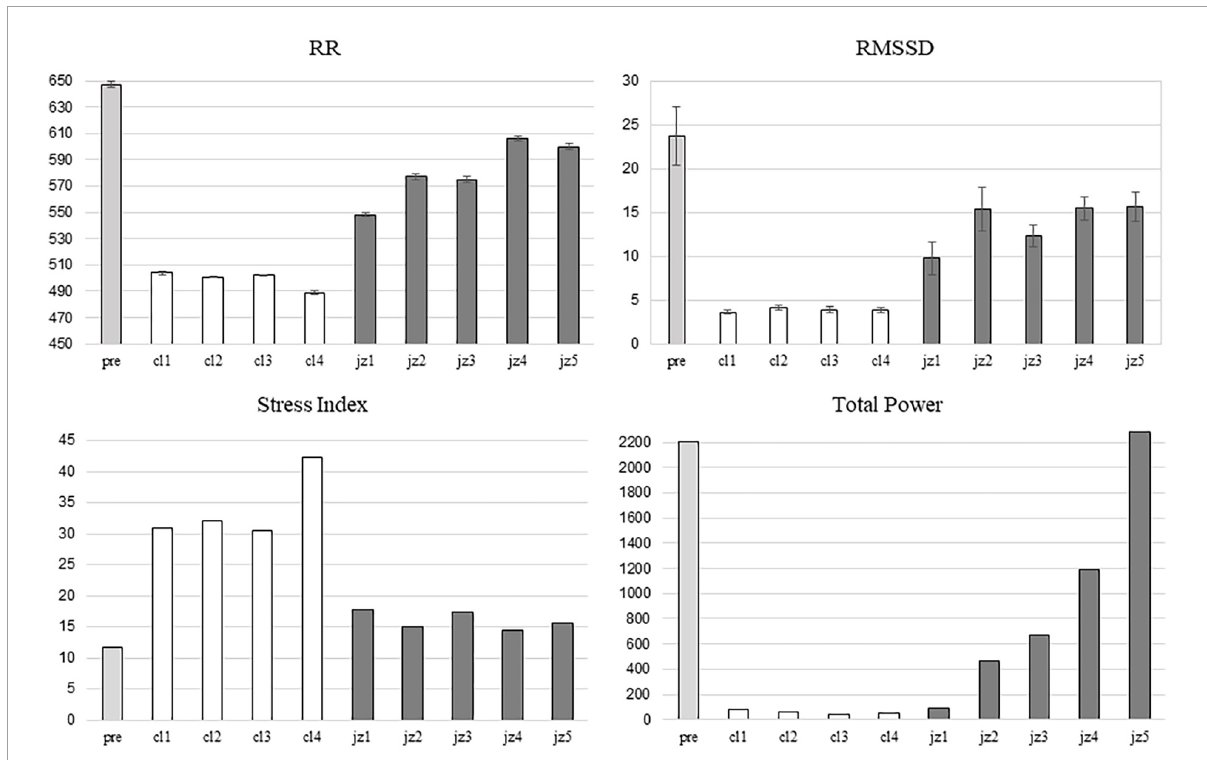
FIGURE1 Mean value of RR, RMSSD, Stress Index and Total power recorded in the pianist during the basal period (pre, light grey bars), the 4 classical pieces (cl1-cl4, white bars) and the 5 jazz pieces (jz1-jz5, grey bars) are shown.